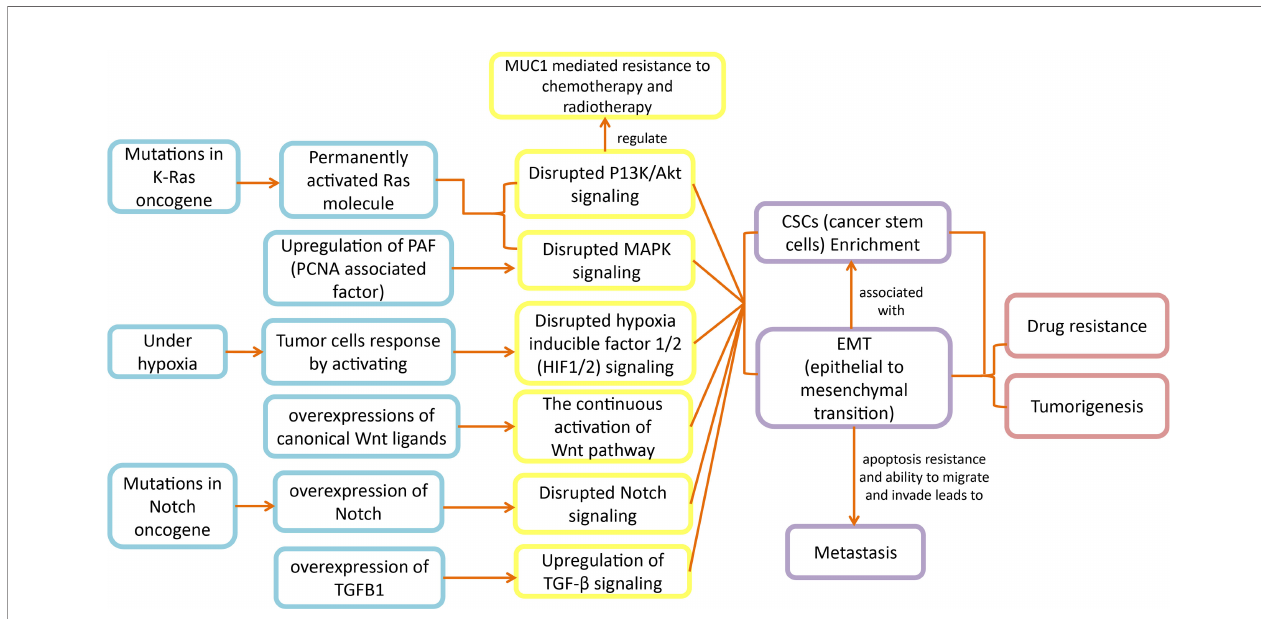
FIGURE 1 | Disrupted pathways in pancreatic cancer: Disruptions in K-Ras, hypoxia, Notch signaling, MAPK, PI3K/Akt and TGF- b signaling pathways lead to EMT and CSCs development, which ultimately expedite metastasis and chemoresistance in pancreatic cancer